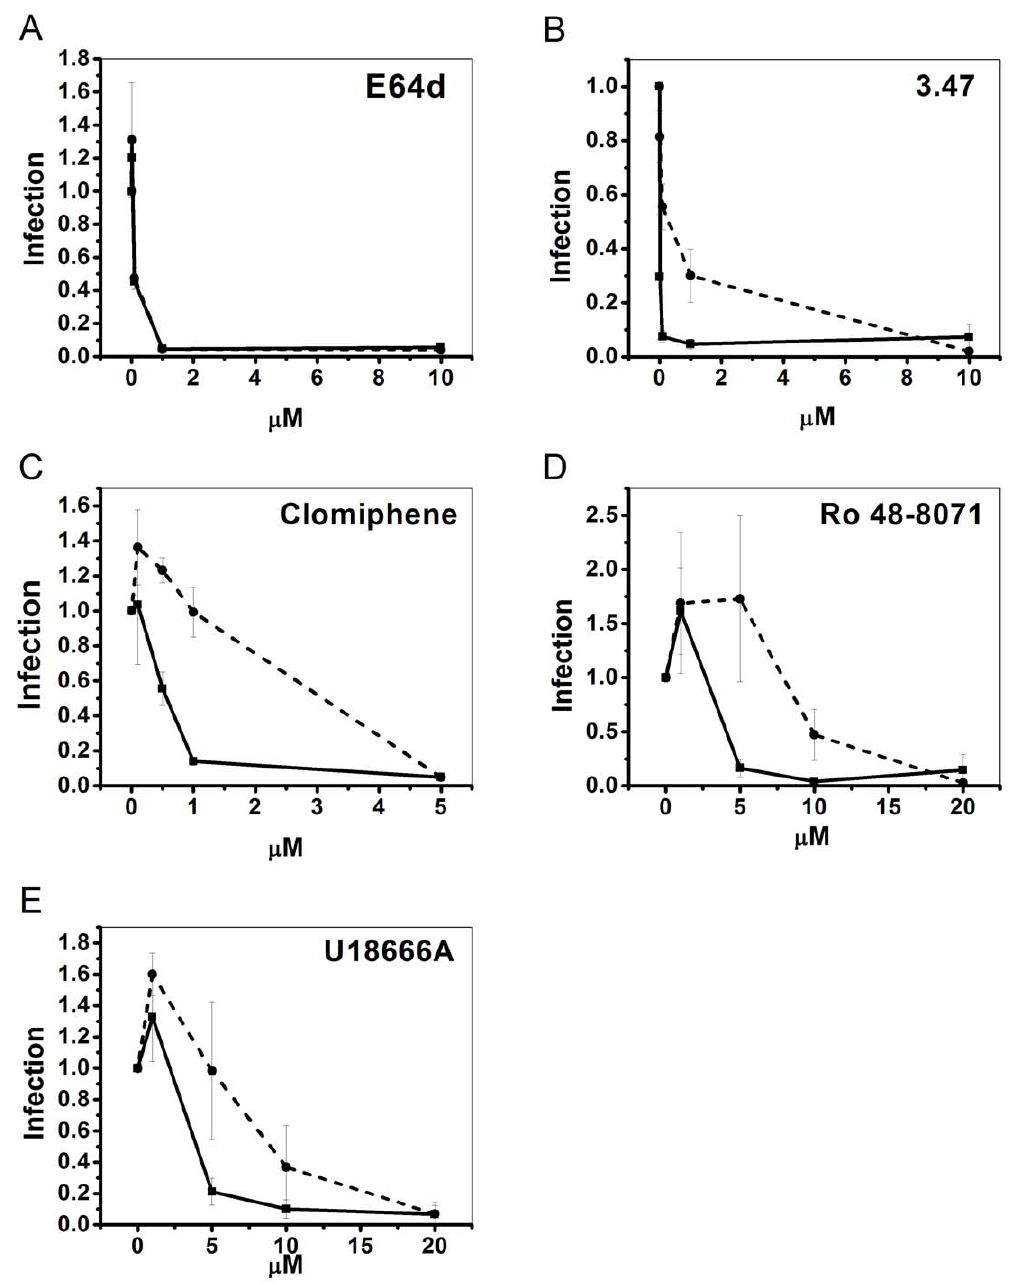
Figure 6. CADs inhibit EBOV GP-mediated infection in an NPC1-dependent manner. Parental CHO cells ( 2222 ) and stably overexpressing CHO NPC1 cells ( 2 2 2 ) were pre-treated with the indicated concentration of inhibitor for 1 hr at 37 u C, and then infected with VSV- GP D for 18 hr in the continued presence of inhibitor. Each concentration of inhibitor was tested (in duplicate) in the following number of experiments: E64d (n=2), compound 3.47 (n=2), clomiphene (n=3), Ro 48-8071 (n=3), and U18666A (n=4). Infection values were normalized to DMSO treated samples and averaged across experiments. Error bars represent standard error.